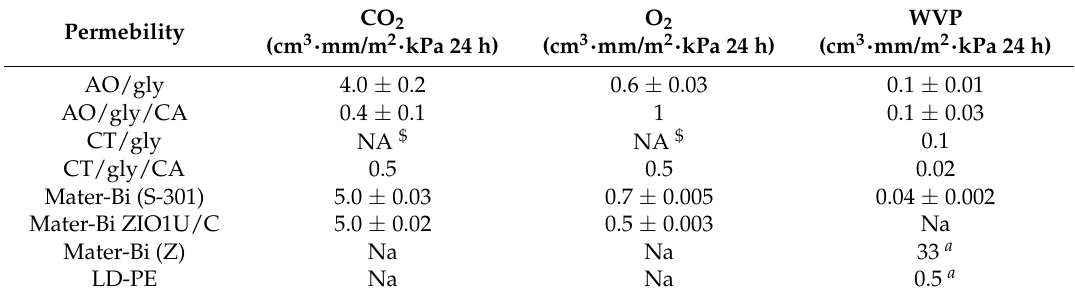
Table 2. Gas permeability of AO-based films compared to selected commercially available materials.